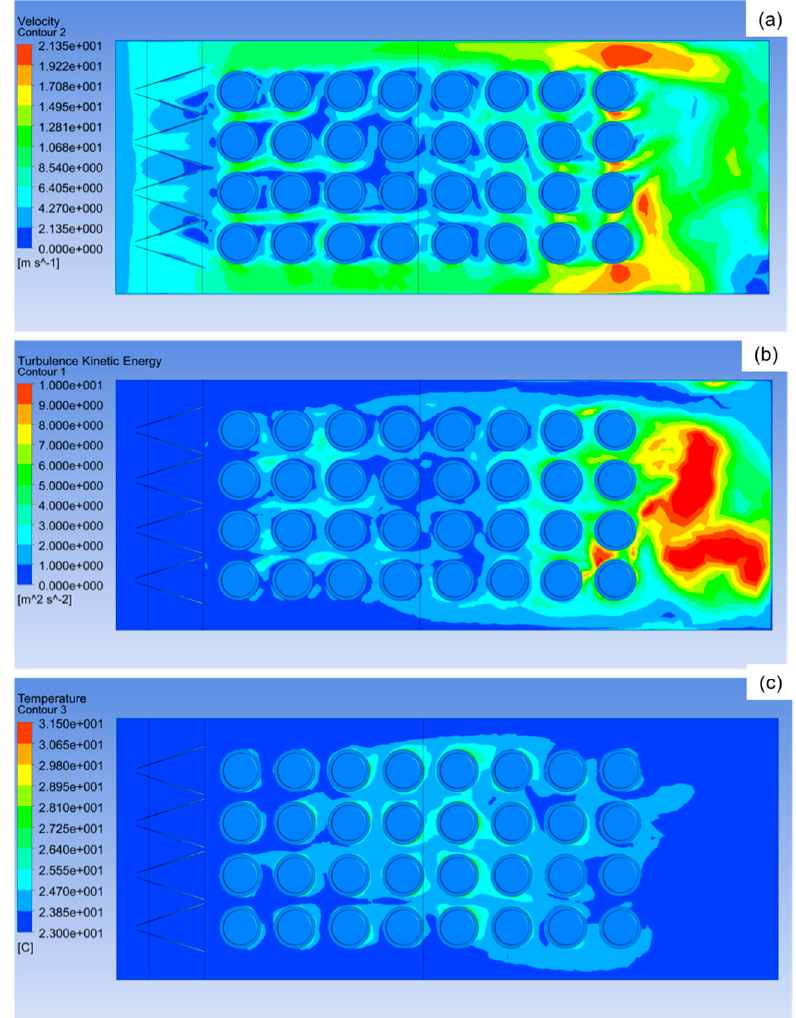
Figure 9. Contours of ( a ) velocity; ( b ) turbulence kinetic energy; and ( c ) temperature in the horizontal plane at 52 mm from the bottom of the battery pack for Case 3.